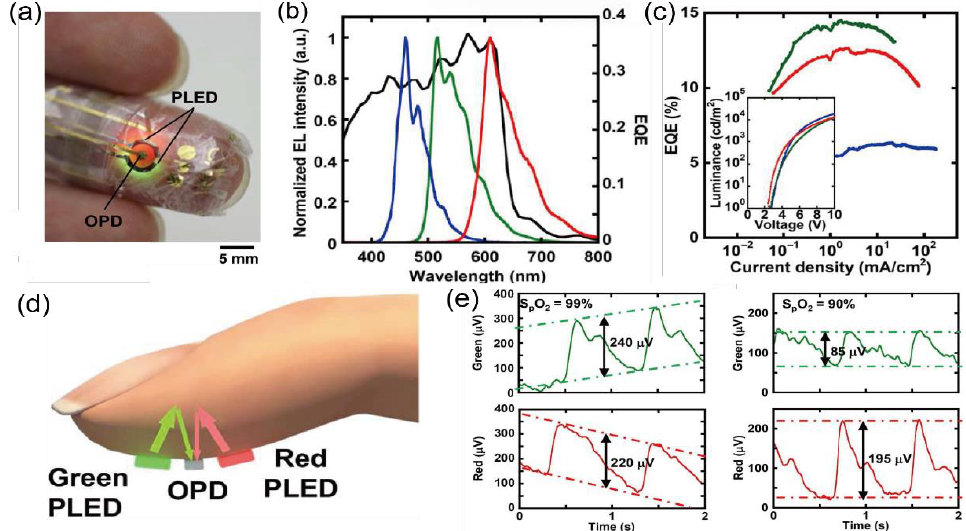
Figure 10. ( a ) Image of an ultra-flexible organic device used on the finger. ( b ) External quantum effieciency (EQE) of organic photodetector (OPD) (black line) according to the wavelength of light with polymer light-emitting diode (PLED) blue (blue line), green (green line), and red (red line). ( c ) Current density and EQE correlation characteristics in ultra-flexible PLED. ( d ) Working principle of the reflection mode pulse oximeter on the finger. ( e ) Output signal of OPD obtained using the ratio of oxyhemoglobin in blood. The green and red lines signify signals when the green and red PLEDs work, respectively. The left figure is the signal when SpO2 is 99%, and the right figure is the signal when SpO2 is 90%. Adapted with permission from, [36] AAAS, 2016.